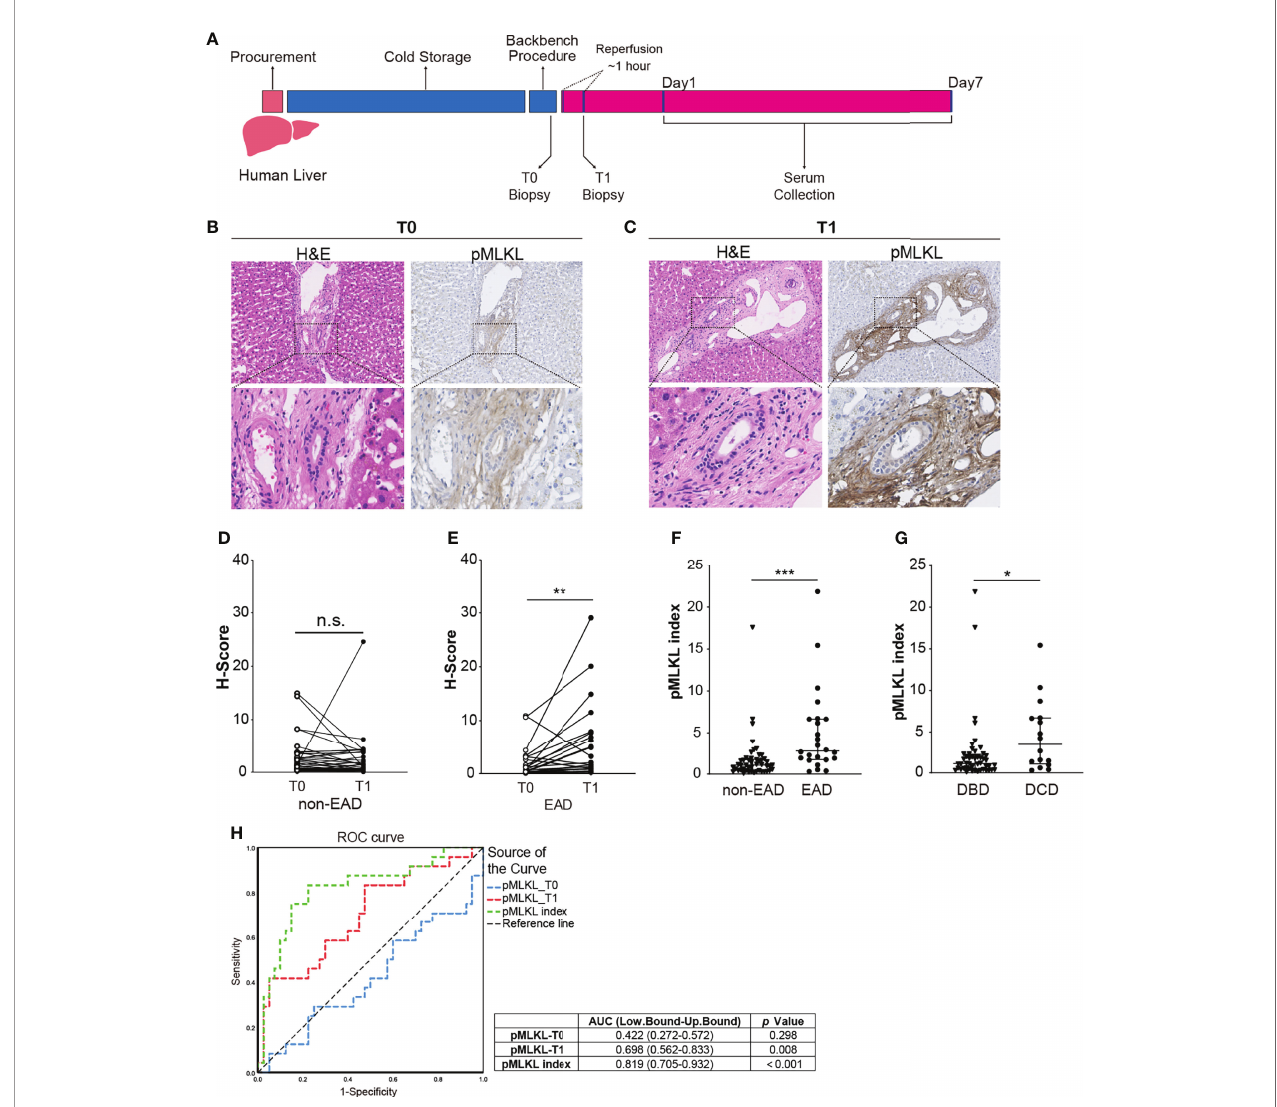
FIGURE 2 | Periportal pMLKL expression in human LT biopsies. (A) Human graft livers were procured and stored in cold preservation solution following a conventional protocol. Liver biopsies were collected at the end of the backbench procedure (T0) and 1 hour after reperfusion (T1). Postoperative serums were collected in the fi rst 7 post-LT days. (B, C) Representative microscopic images of HE and pMLKL staining on T0 and T1 graft livers that developed post-transplant EAD were shown (magni fi cation, 100X). Enlarged images from the boxed area are shown in the bottom panel (magni fi cation, 400X). The pMLKL positive cells were mainly localized at the periportal region, distributed within the stroma of the portal triad adjacent to the wall of the portal vein, hepatic artery, and biliary epithelium. (D, E) Paired comparison of pMLKL scores at T0 and T1 were performed separately in non-EAD and EAD groups (Wilcoxon matched-pairs signed-rank test). pMLKL-T1 was signi fi cantly higher than pMLKL-T0 in recipients that developed EAD compared to the non-EAD group. (F) pMLKL index were compared in non-EAD and EAD groups (Mann-Whitney test). The pMLKL index was signi fi cantly higher in the EAD group versus the non-EAD group. (G) pMLKL index were compared in DBD and DCD livers. (Mann-Whitney test). A signi fi cantly higher pMLKL index was observed in DCD liver grafts compared to the DBD livers (H) ROC curve showing the discriminative ability of pMLKL_T0, pMLKL_T1, and pMLKL index in the development of EAD. Data are presented as the median and interquartile range (IQR). n.s., not signi fi cant; *p < 0.05; **p < 0.01; ***p <